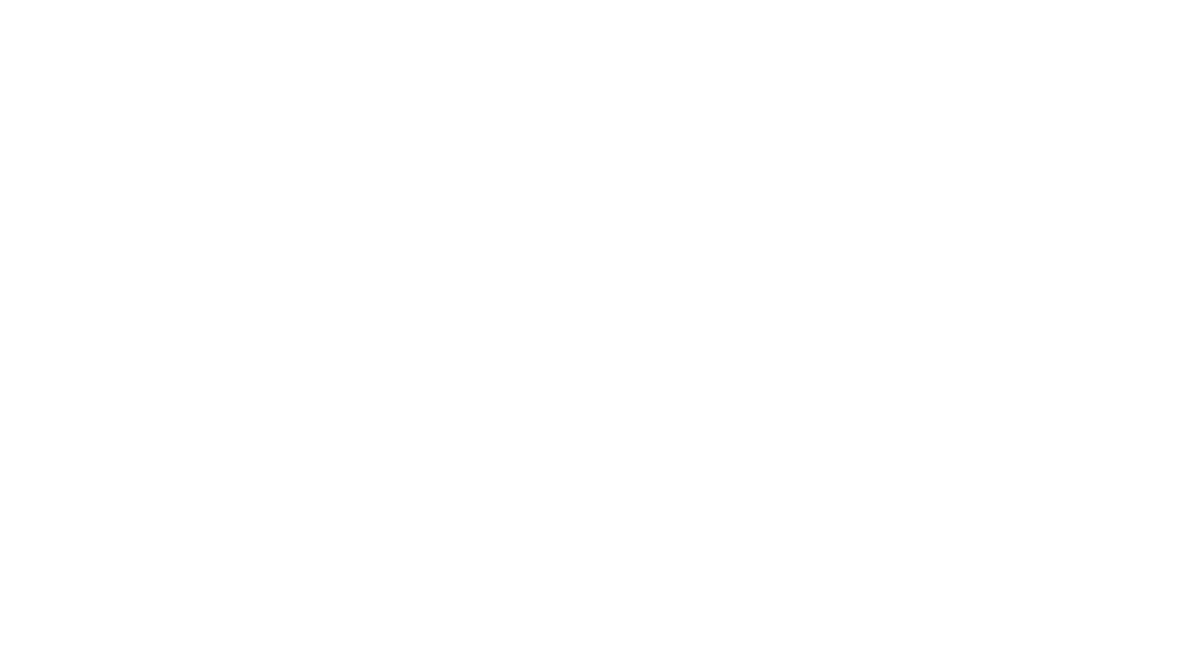
Frontiers in Physics |